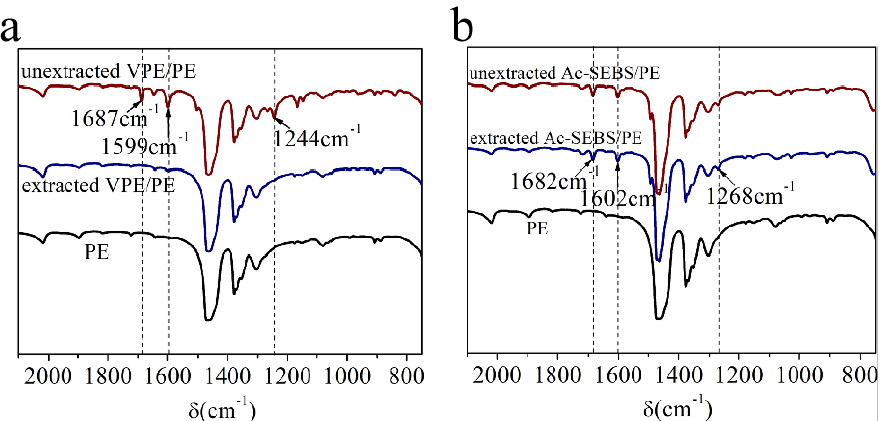
Figure 5. Infrared spectrum pre-and post-extraction of 1-(4-vinyloxy)phenylethenone (VPE / PE) and